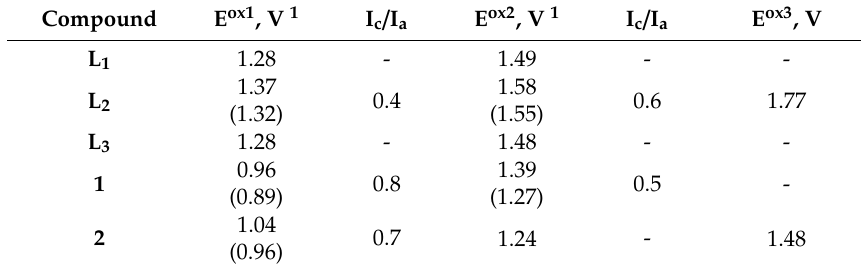
Table 1. The CV data for thioethers L 1 – L 3 and triphenylantimony(V) catecholates 1 and 2 in CH 2 Cl 2